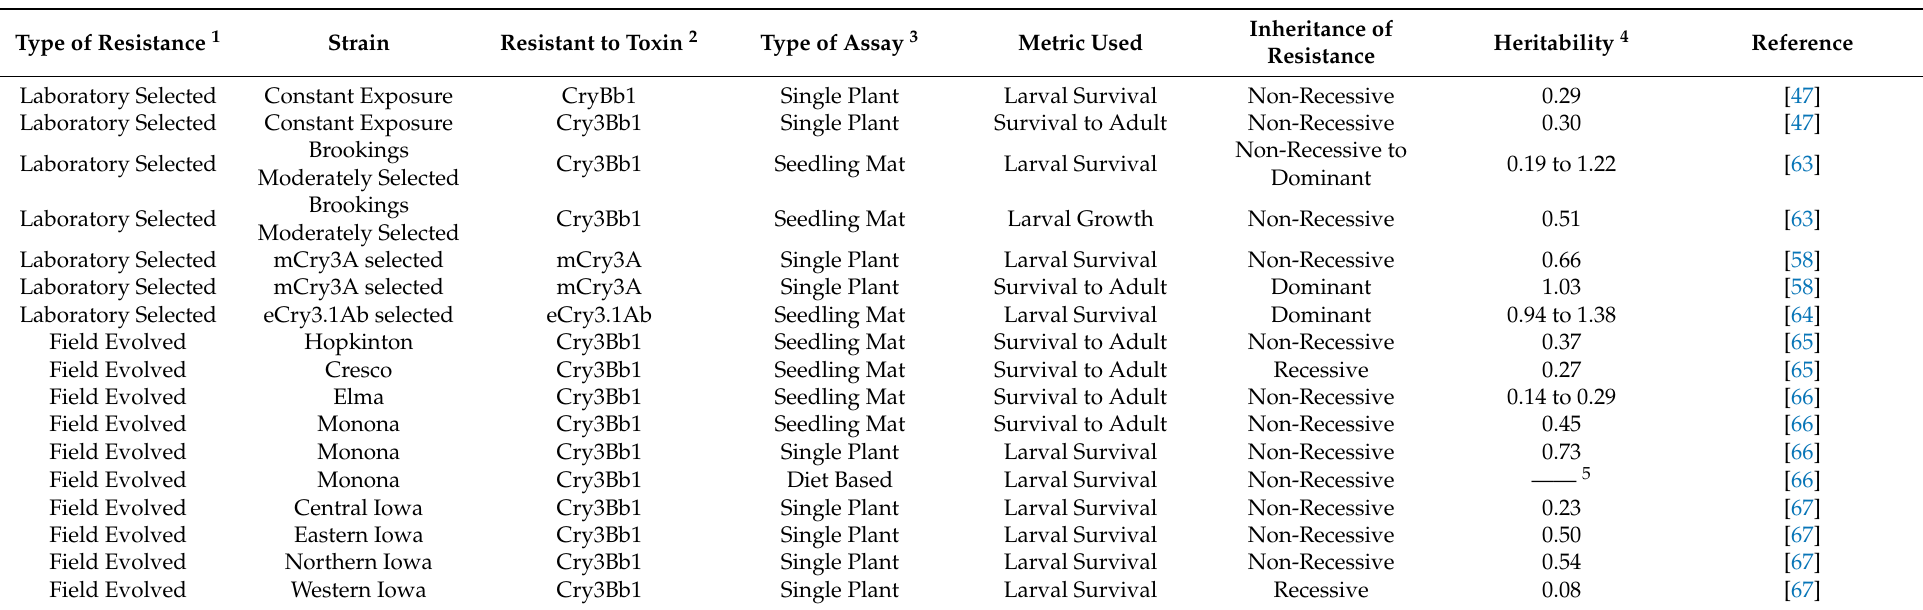
Table 1. Studies testing the inheritance of resistance to Bacillus thuringiensis (Bt) maize by western corn